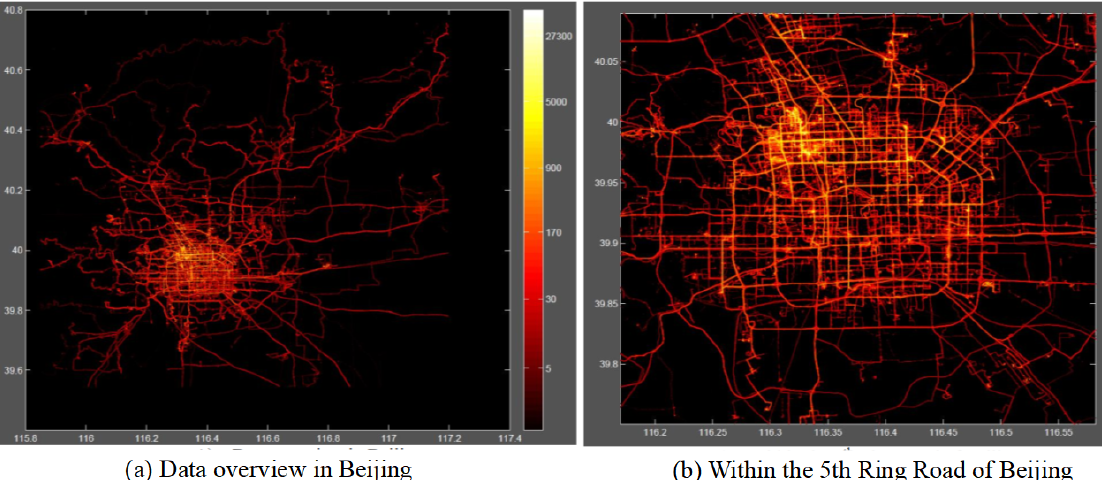
Figure 5. ( a , b ) Overview of D2